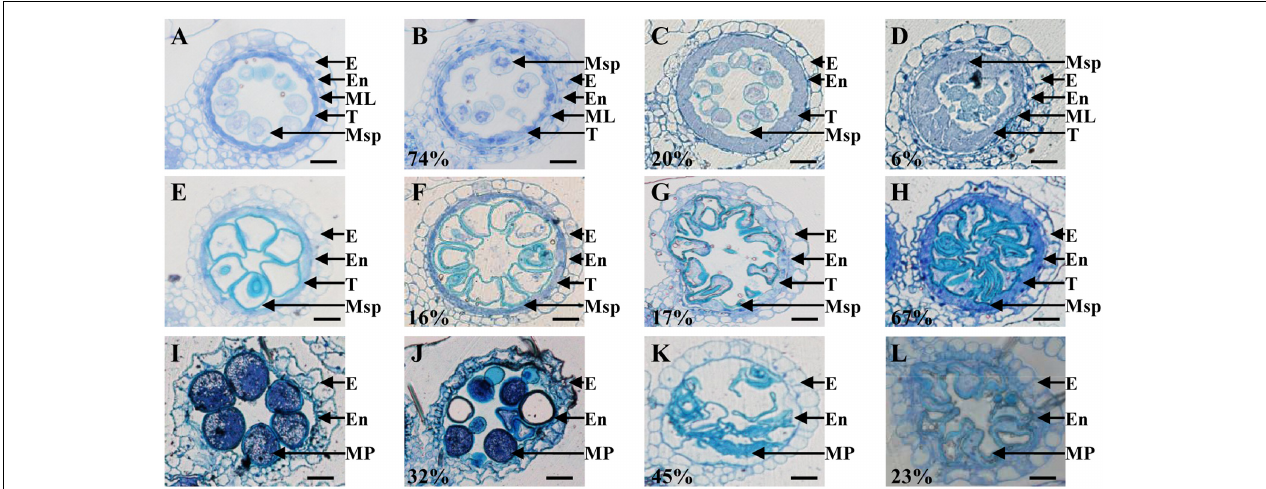
FIGURE 3 | Histological comparison of anther development in the wild type and osemf2b-4 . Three stages of anther development in the wild type and osemf2b-4 are compared. The images are of cross sections through a single locule. Wild type sections are shown in (A,E,I) , and others show osemf2b-4 sections. (A–D)